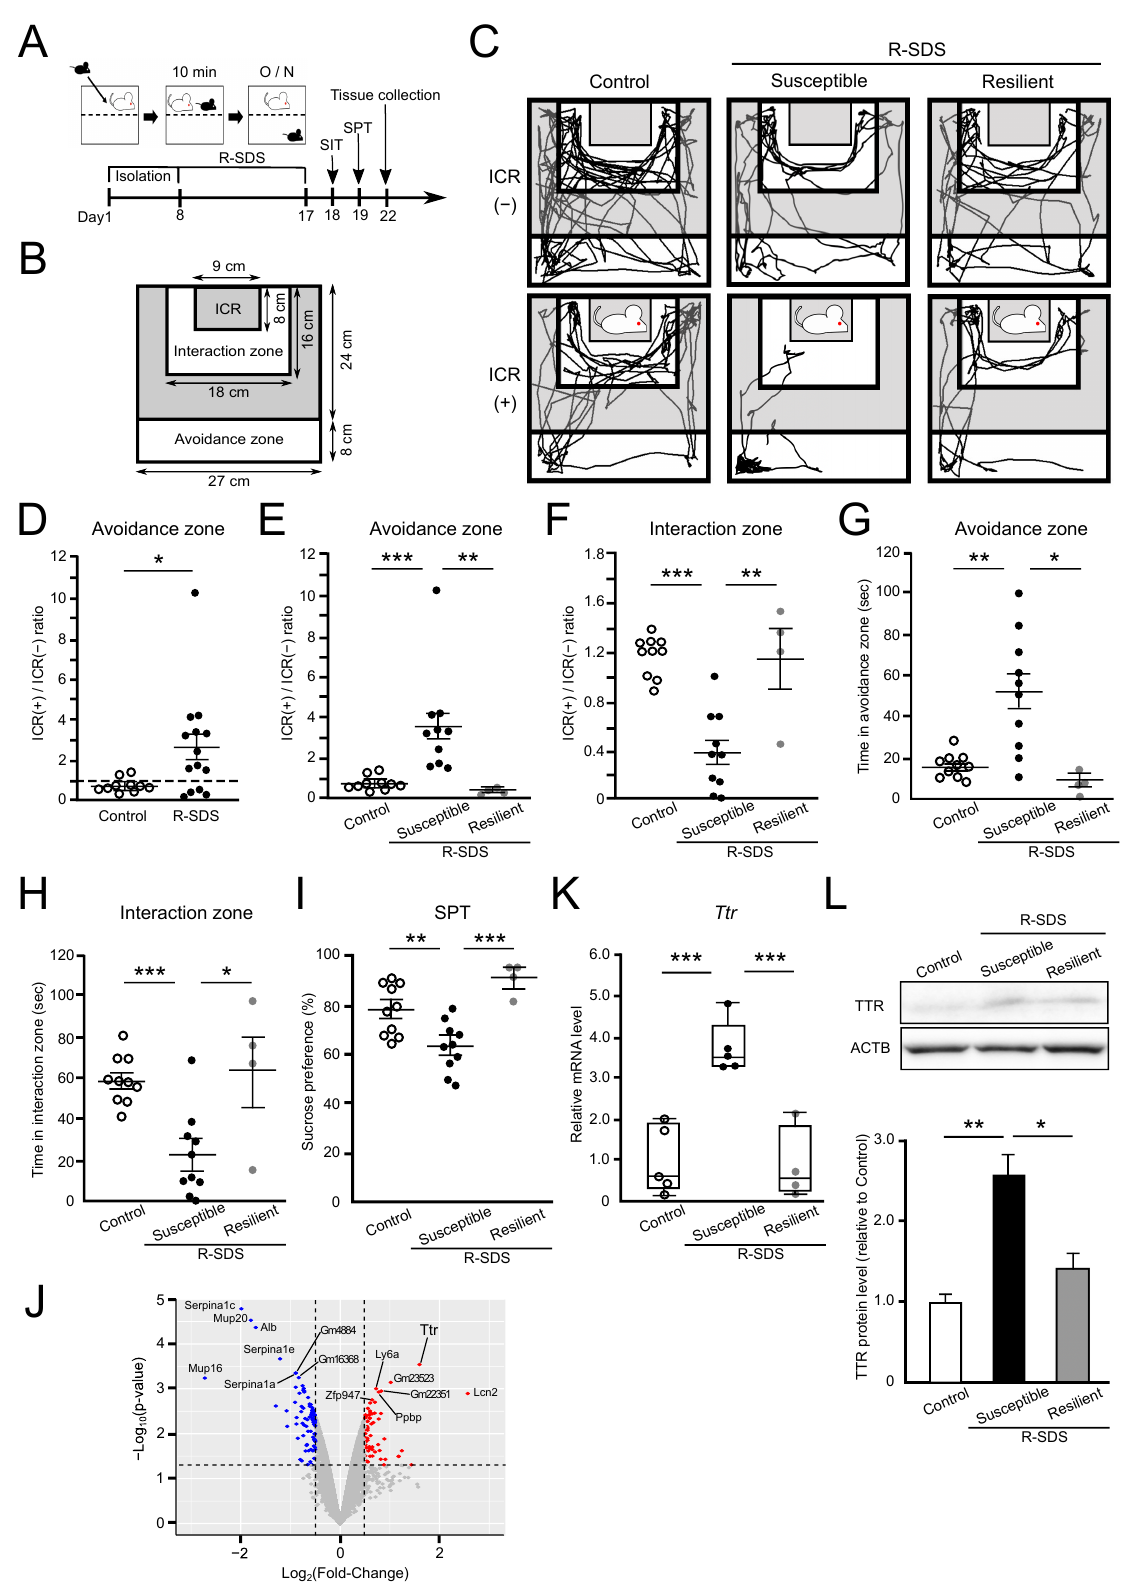
Figure 2. Preparation of repeated social defeat stress (R-SDS)-induced depression mouse model, behavioral tests, and gene expression analyses. ( A ) Schedule of mouse preparation and analyses.